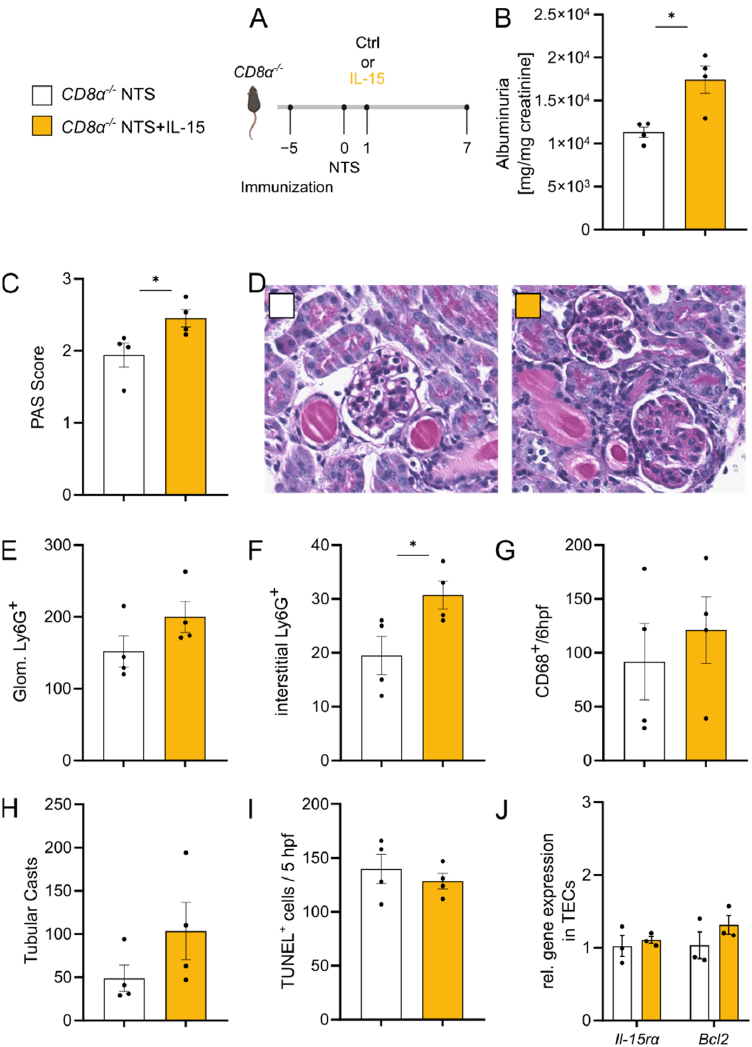
Figure 5. rIL-15 in NTS has no beneficial effect in CD8 α − / − mice. ( A ) Experimental timeline of 7 days NTS in CD8 α − / − mice with a single low-dose rIL-15 intervention. ( B ) Ratio of urinary albumin to creatinine. ( C ) Scoring of PAS-positive material and ( D ) representative staining in murine kidney tissue. ( E ) Immunohistochemical quantification of glomerular and ( F ) interstitial Ly6G + cells and ( G ) renal CD68 + in 6hpf. ( H ) Quantification of tubular cast formation in PAS-staining of kidney tissue. ( I ) Quantification of TUNEL + cells in 5 hpfs. ( J ) Relative gene expression of Il-15r α and Bcl2 in renal tubular epithelial cells. Black dots represent individual values of respective mice. * p ≤ 0.05. Statistical analysis used was Student’s t -test or Mann–Whitney test. All data are mean ± SEM.